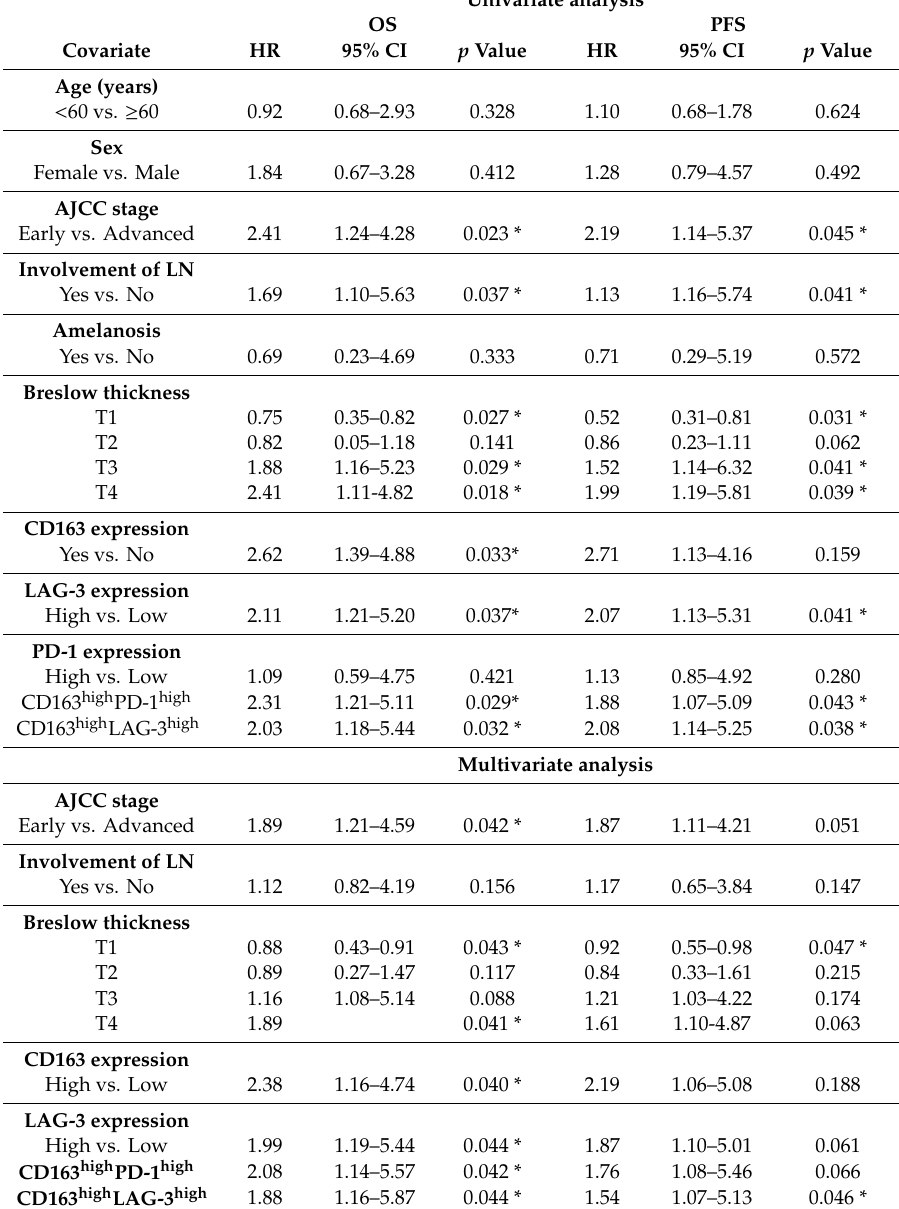
Table 4. Univariate and multivariate analyses for overall survival and progression-free